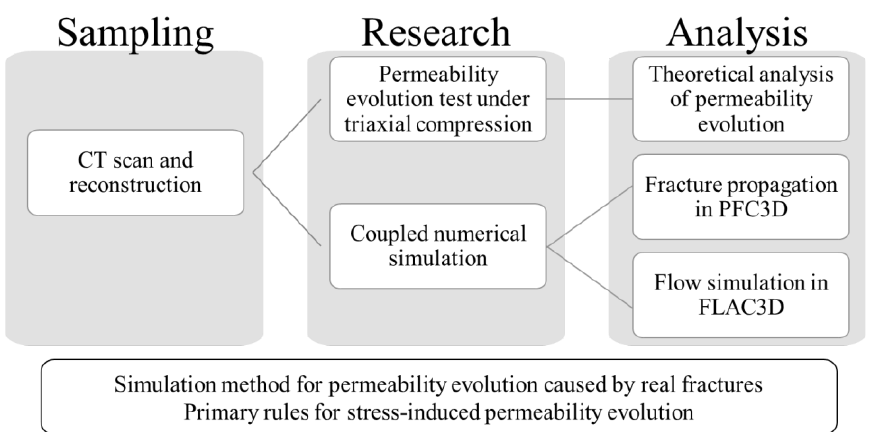
Figure 1. Flowchart illustrating the research strategy.